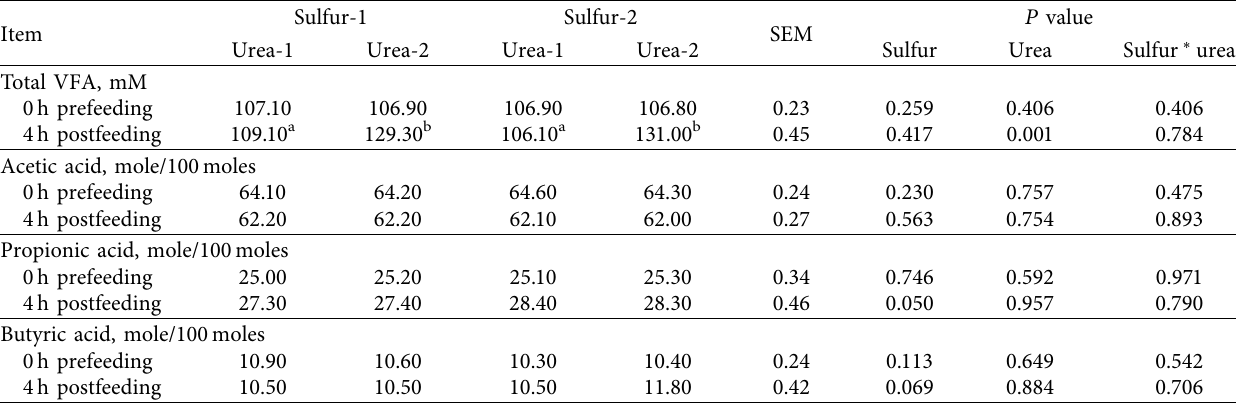
Table 5: Effect of sulfur and urea levels on total VFA and its molar proportions in dairy cows.